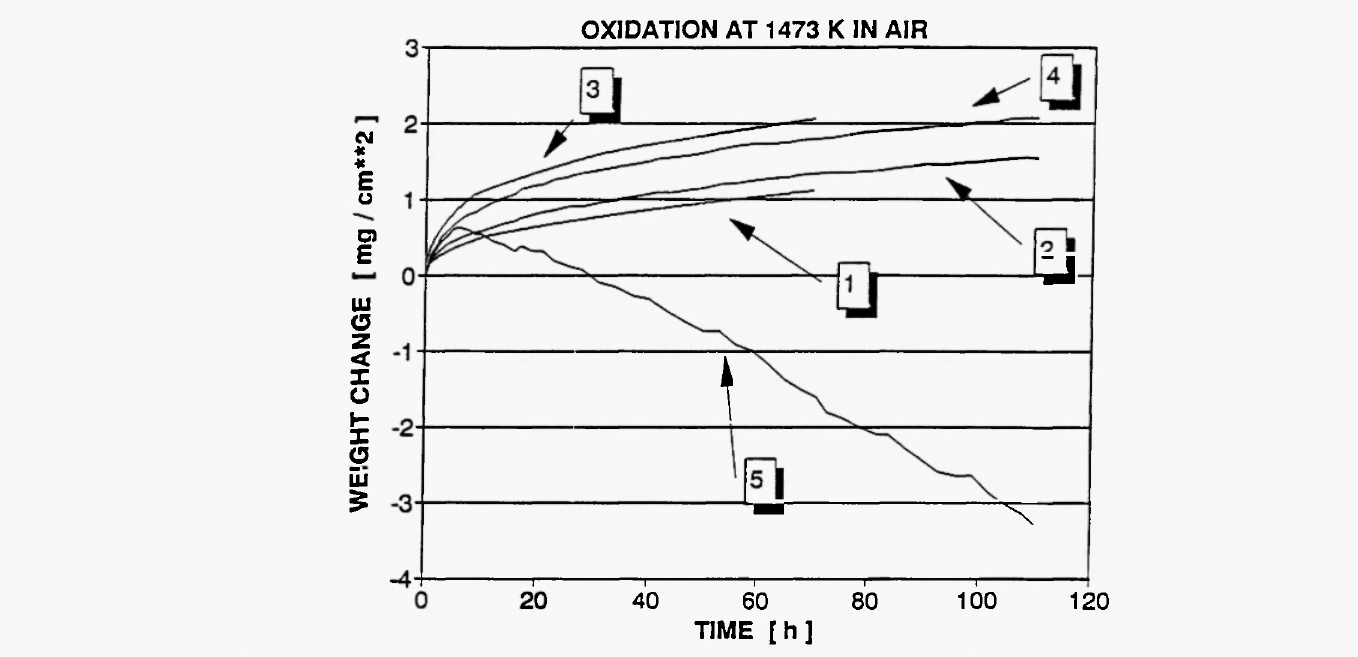
Fig. 7: Thermal cycling results at 1473K (1 cycle - 1 h) compared to isothermal oxidation results: 1 , 2- alloy Fe- 19Cr-5Al, isothermal and thermal cycling conditions, respectively; 3, 4 - alloy Fe-19Cr-5Al + 0.27Y, isothermal and thermal cycling conditions, respectively; 5 - alloy Fe-23Cr-5Al, thermal cycling conditions (tested for comparison as an analogous alloy to the unmodified one but having lower purity).